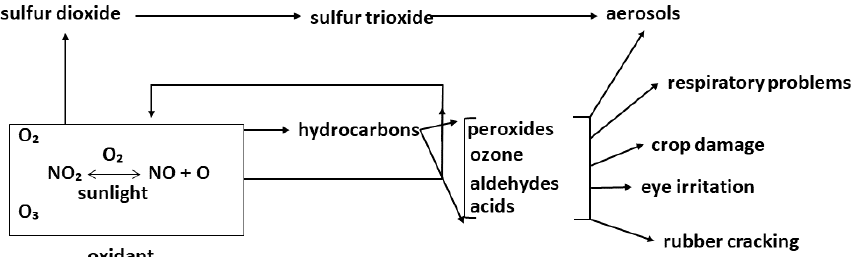
Figure 2. Schematic representation of the reactions in polluted air leading to smog symptoms (adapted from Haagen-Smit et al., 1953).